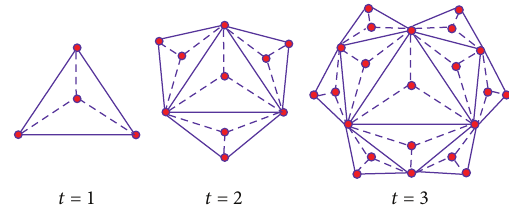
Figure 1: (Color online) construction of the deterministic planar network 𝑀(𝑡) ,showingthreestepsoftheiterativeprogress.Thesolid links are iterated links; the dashed links are noniterated